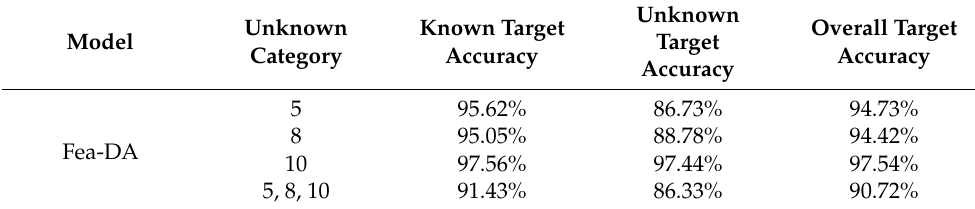
Table 7. Results of 3-type unknown target